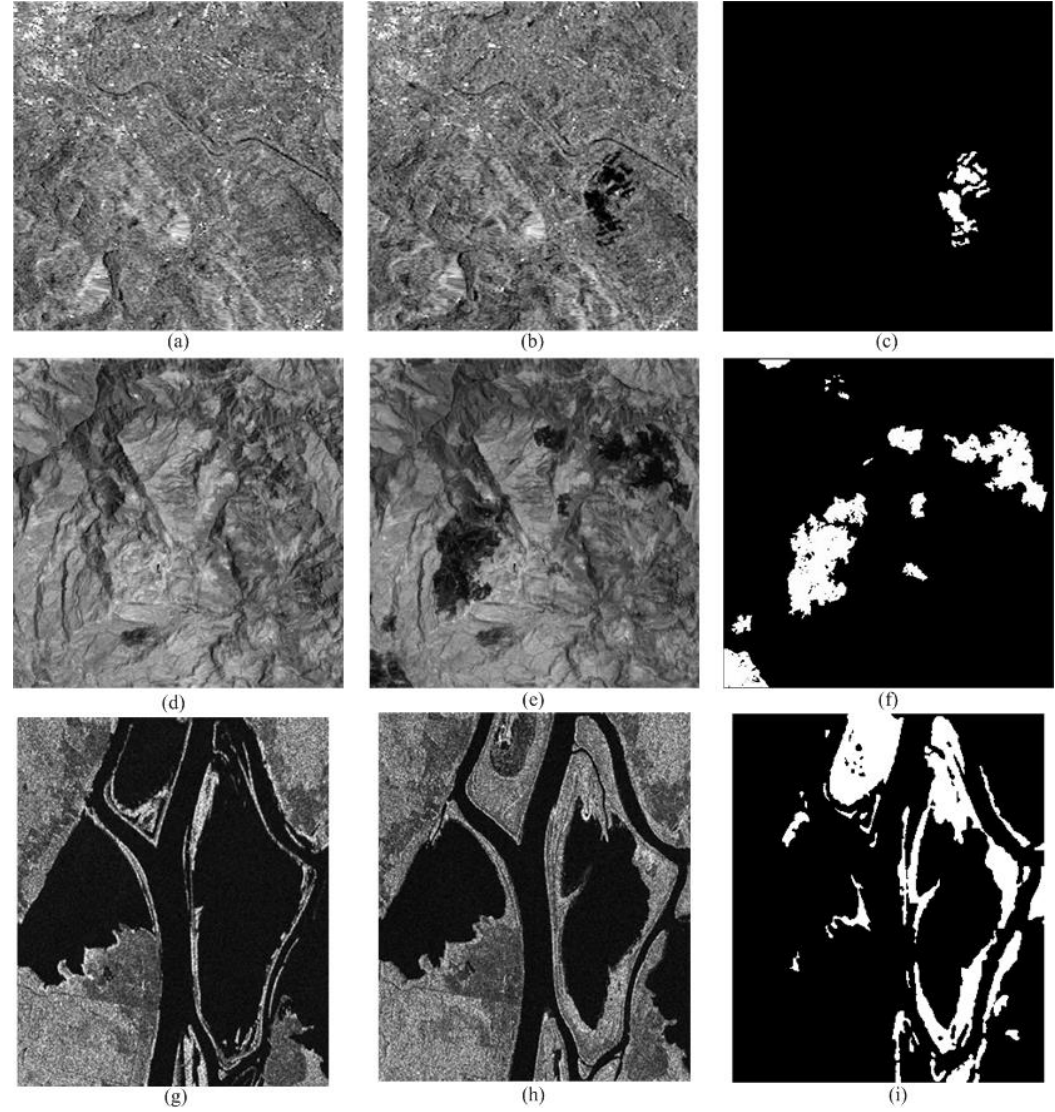
Figure 4. ( a ) Image acquired in April 1999; ( b ) Image acquired in May 1999; ( c ) Ground truth of ( a , b ); ( d ) Band 4 of image acquired in April 2000; ( e ) Band 4 of image acquired in May 2002; ( f ) Ground truth of ( d , e ); ( g ) Image acquired in July 1997; ( h ) Image acquired in August 1997; ( i ) Ground truth of ( g , h ).